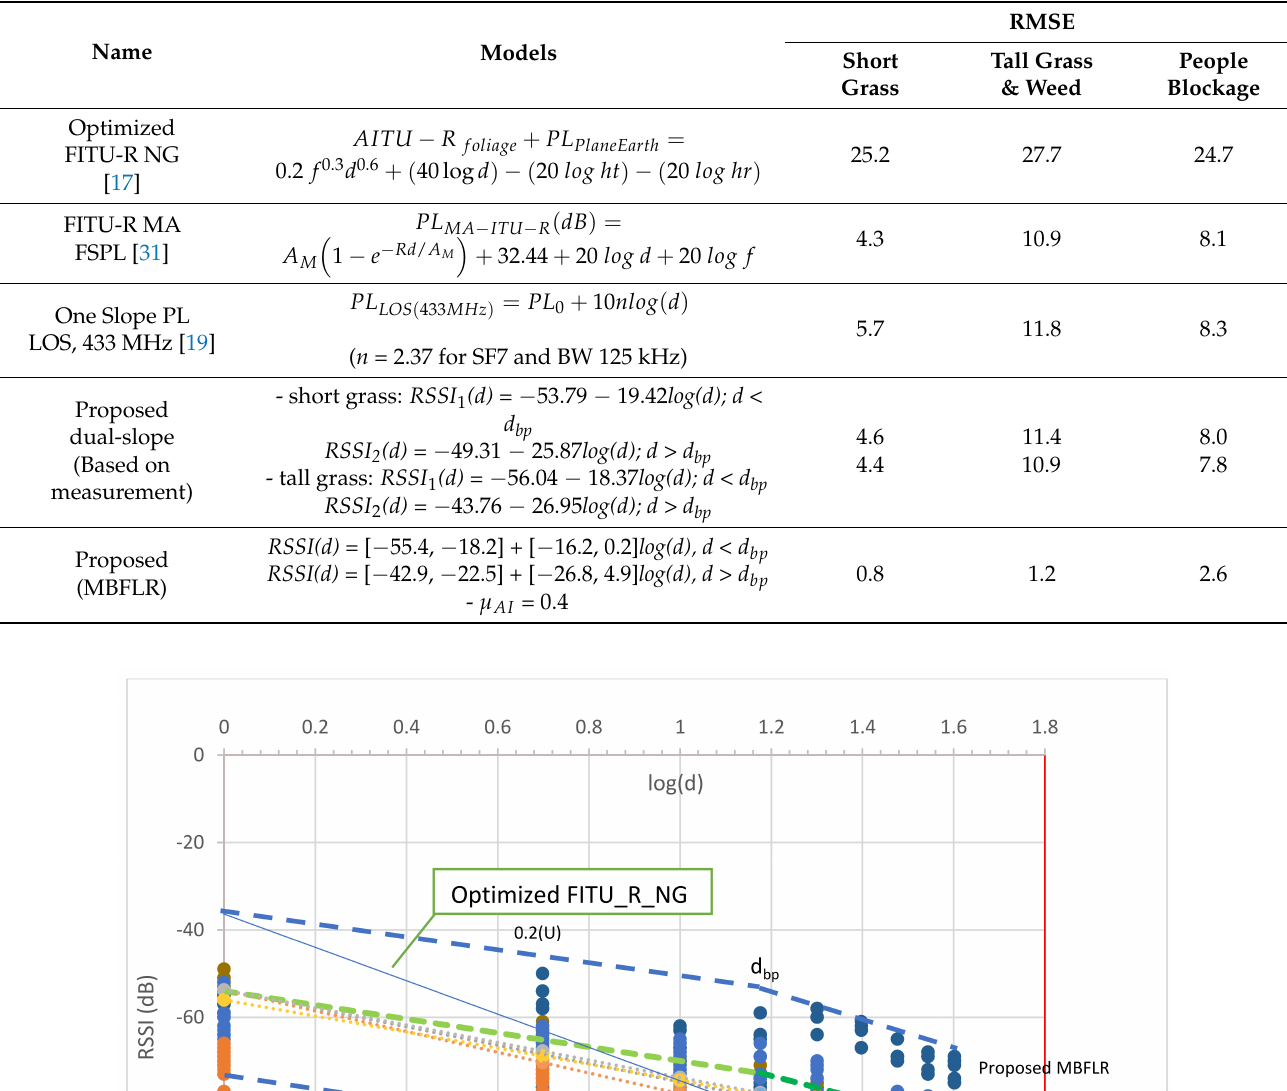
Table 2. Statistical evaluation for each path loss model using RMSE.